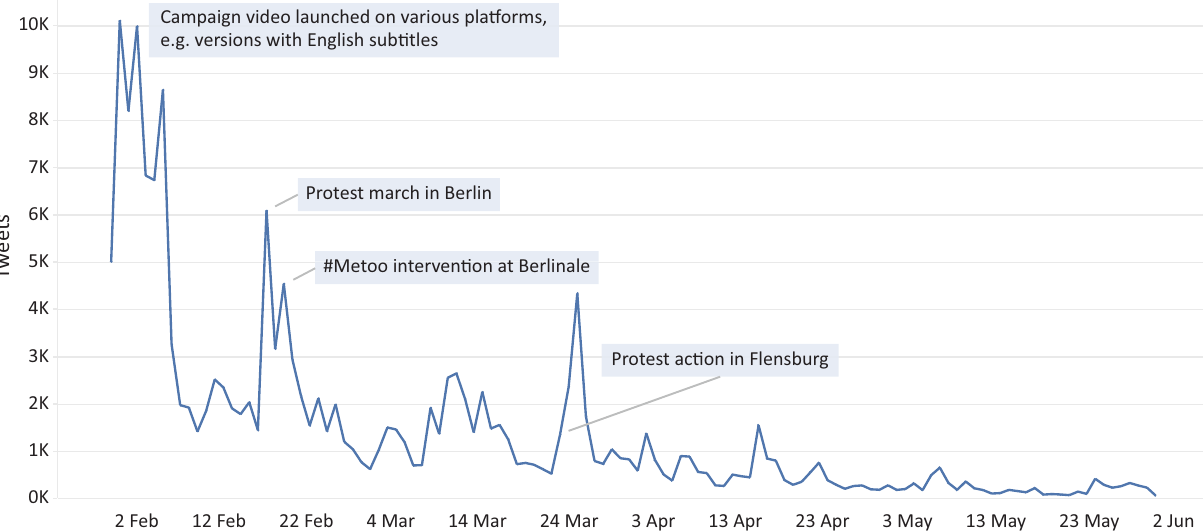
Figure 1. Activity on Twitter around the hashtag #120decibel, showing how offline events typically coincide with increased online activity, following the wide circulation of the hashtag at the start of the campaign on January 30, 2018. of 11,940, whereas the 30th most prominent account (Samtpfote29) only reaches a value of 773. The outde- gree leaders differ in a range from 4,557 (_macmike) to 226